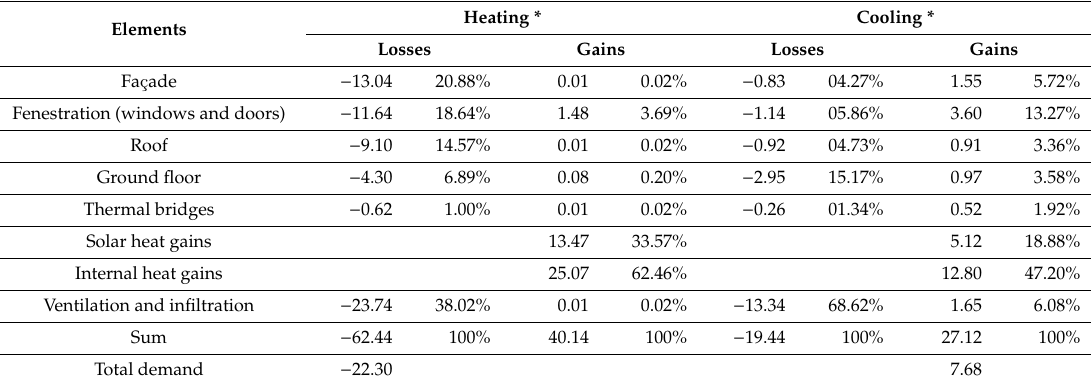
Table 11. Thermal balance. Example 1: Hypothesis 2, Model 1, Constructive solution 1, Climate Zone D3, Orientation North. Thickness 85mm, Insulation Material Expanded Cork.